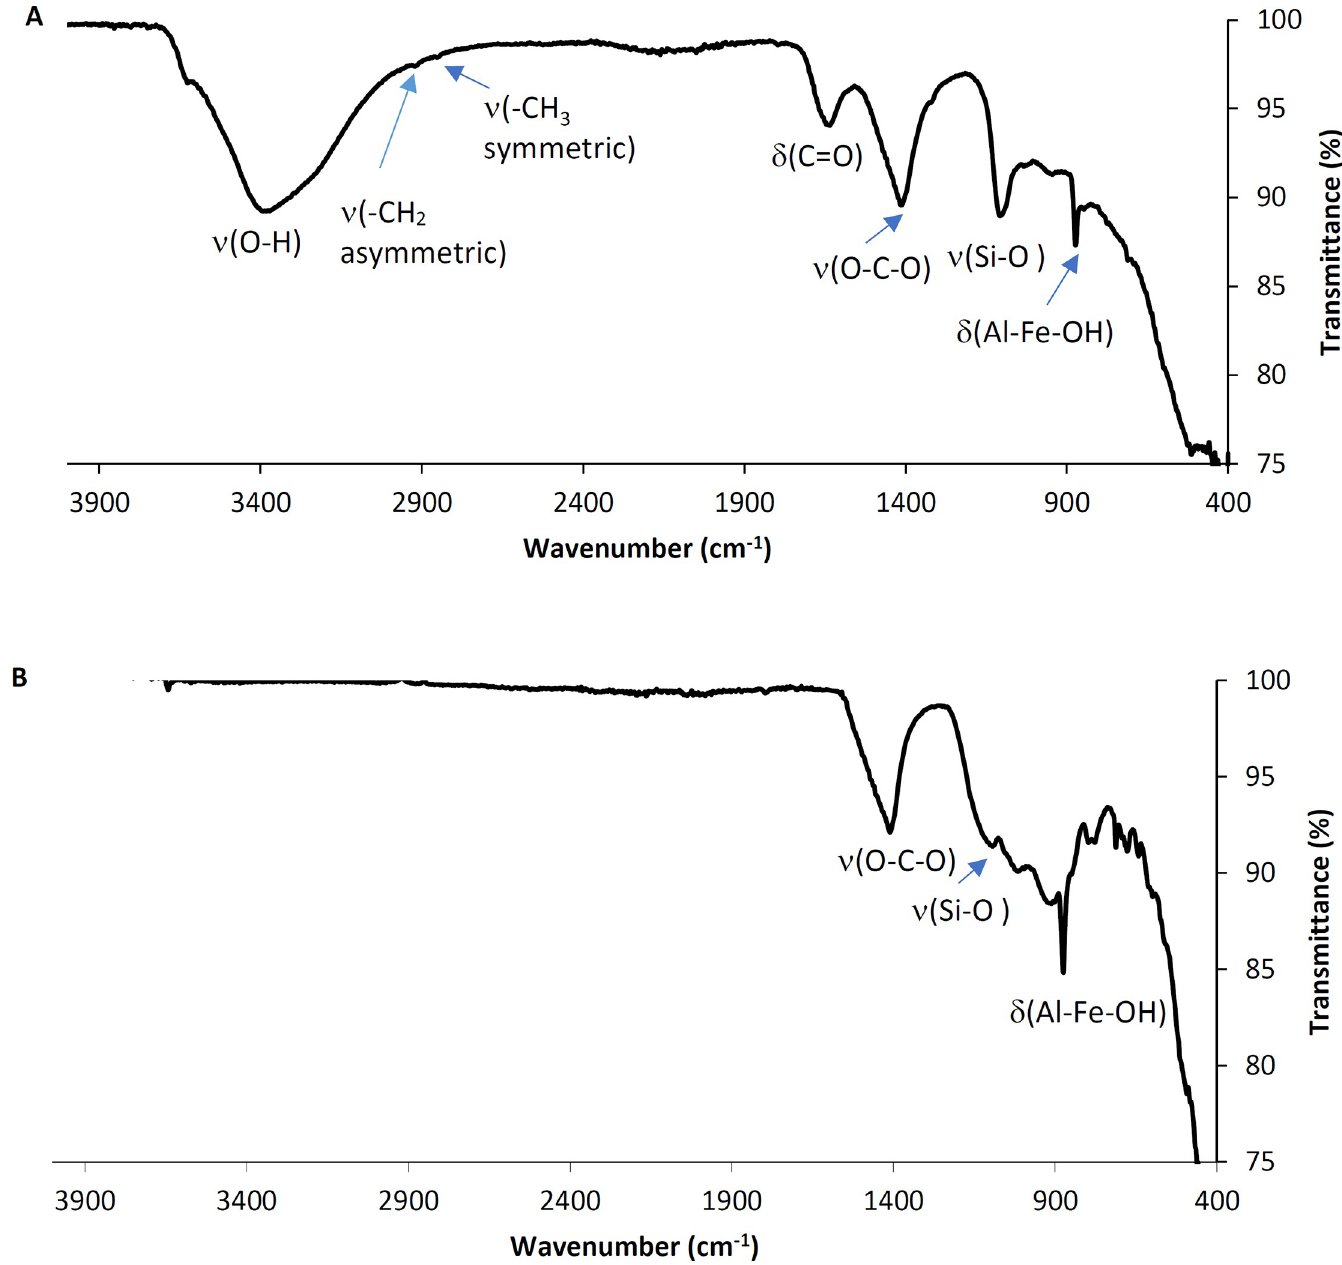
Fig 4. FTIR spectra of (A) MSW-BA and (B) MSW-FA.